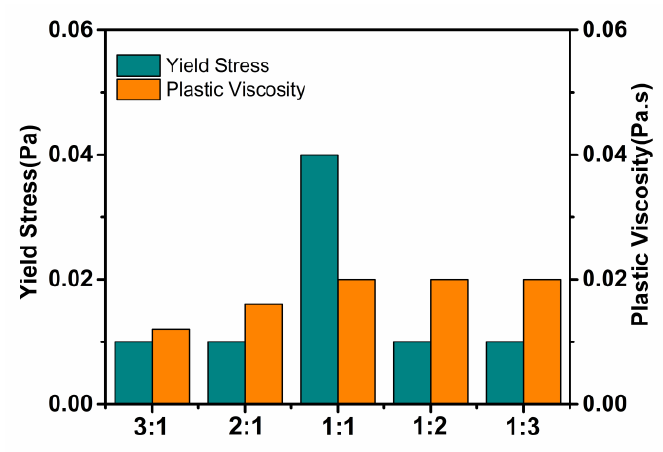
Figure 9. Rheological parameters of AMPS–DMAA copolymers with different charge densities in cement filtrate.